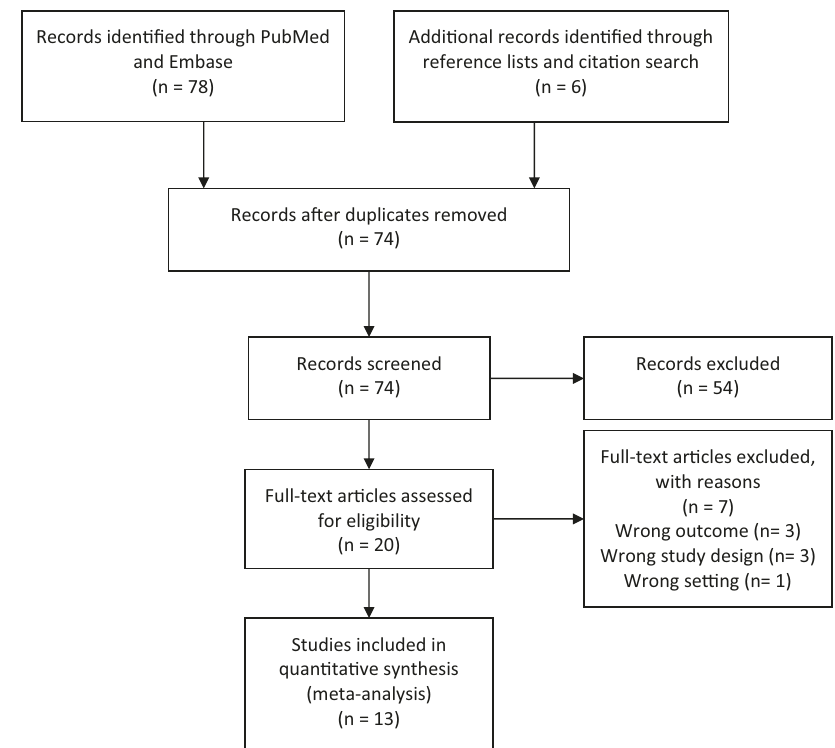
Fig. 1 PRISMA Flow Diagram of selected studies. * PRSIMA = Preferred Reporting Items for Systematic Reviews and